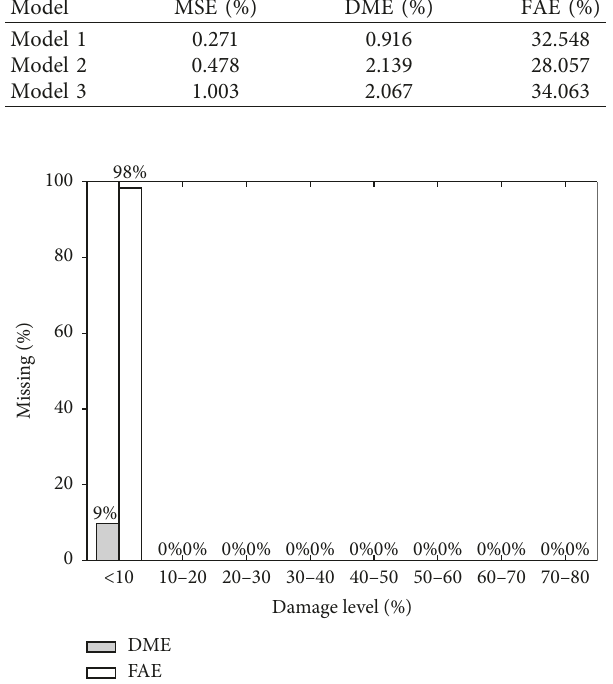
Figure 10: DME and FAE for model 1, spring series case